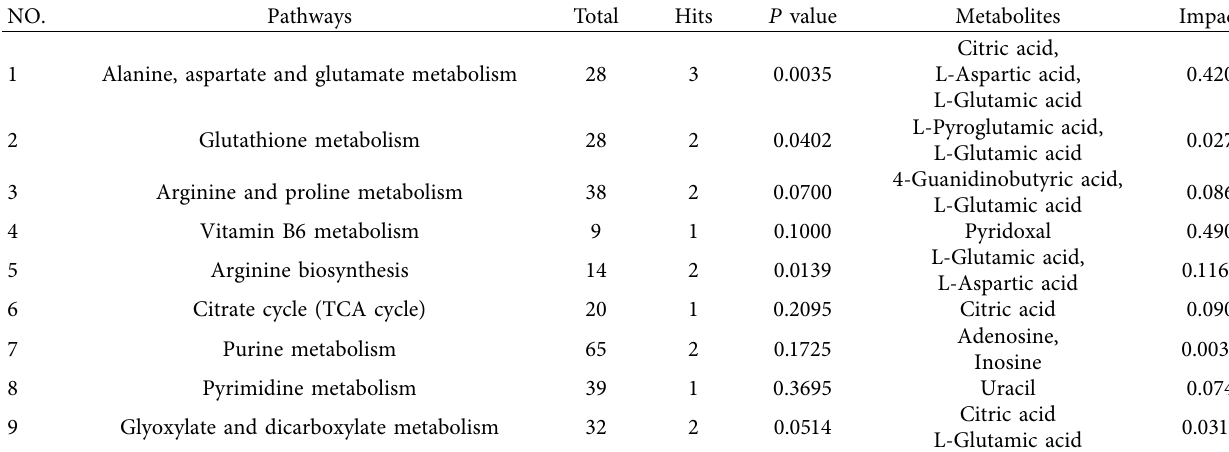
Table 2: Identification of significant pathways in the HF and healthy groups.